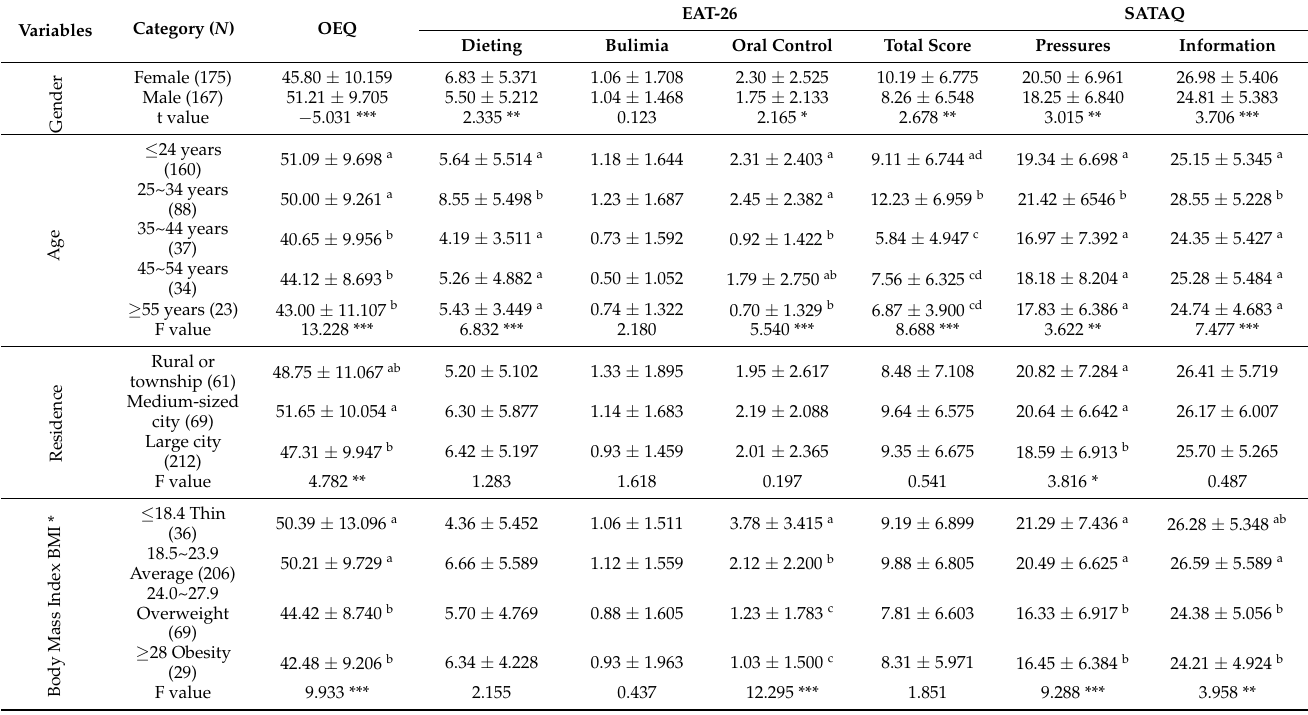
Table 1. Descriptive statistics and differential analysis of participants’ scores on the OEQ, EAT-26, and SATAQ scales. Variables